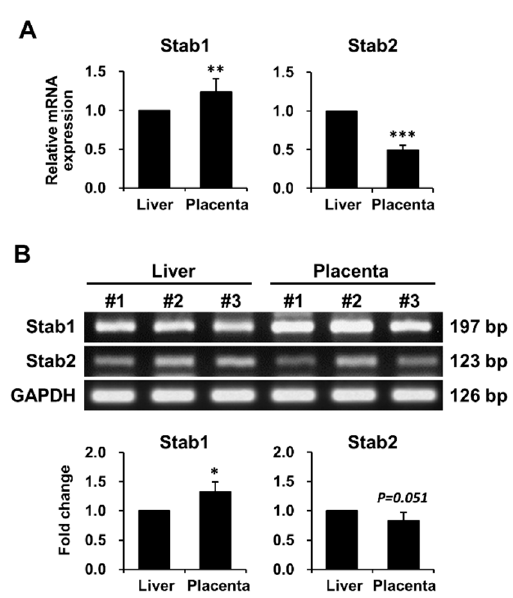
Figure 1. mRNA expression levels of Stab1 and Stab2 in WT female mouse placentas. The mRNA expression levels of Stab1 and Stab2 in mouse placentas were measured using qPCR ( A ) and RT-PCR ( B ) and were compared with those in the liver used as a positive control. The relative expression levels shown in ( A ) were plotted against those of the respective genes in the liver, which were set to 1.0. Intensities of individual bands obtained via RT-PCR shown in ( B ) were determined using ImageJ. Data were normalized to Gapdh expression and calculated as fold change relative to the expression level in the liver, which was set to 1.0. Numbers in ( B ) indicate the representative mice used in the experiment. *, p < 0.05; **, p < 0.01; ***, p < 0.001 versus the positive control; n = 3.